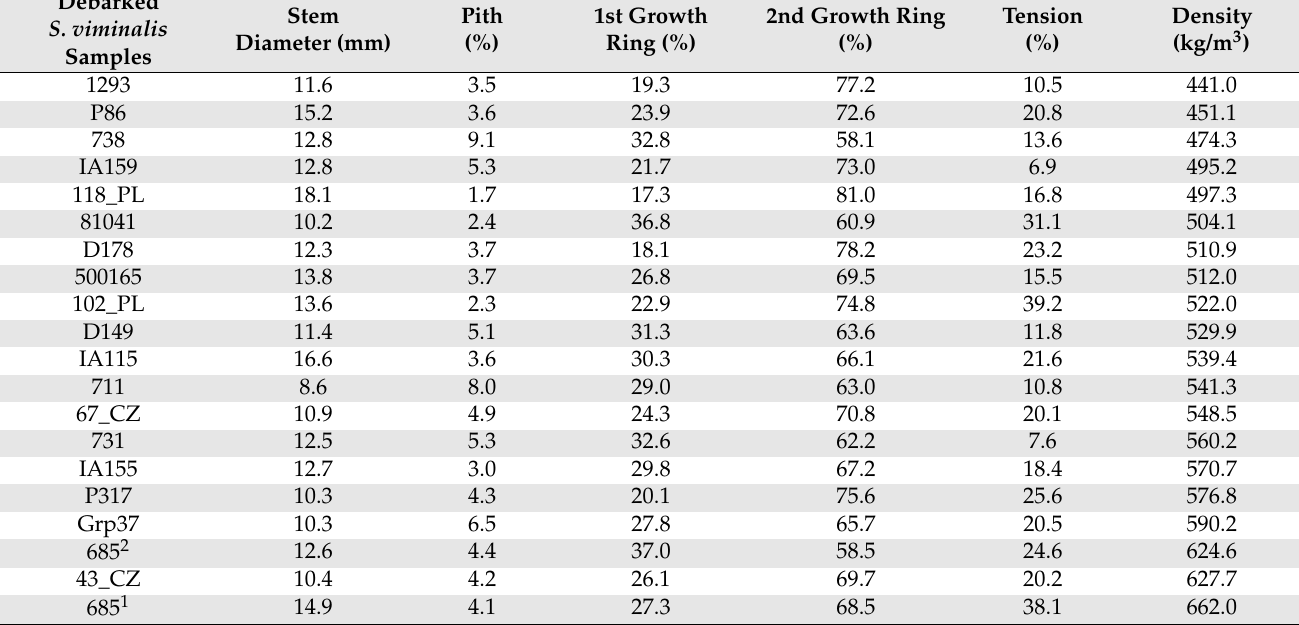
Table 3. Selected S. viminalis clones